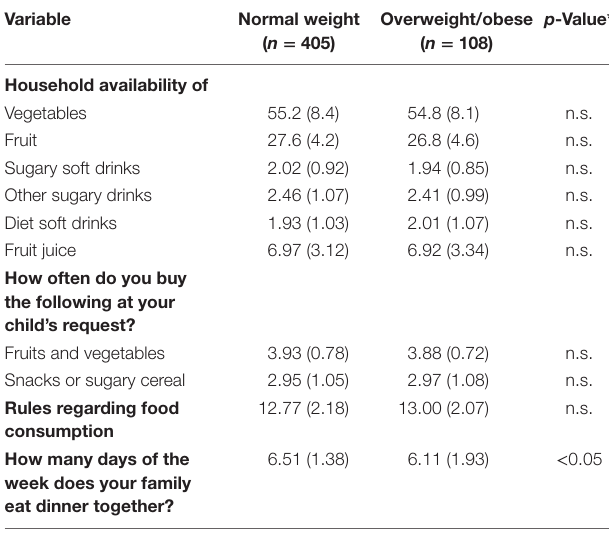
*Chi-square test was used for categorical variables; t-test for continuous variables.